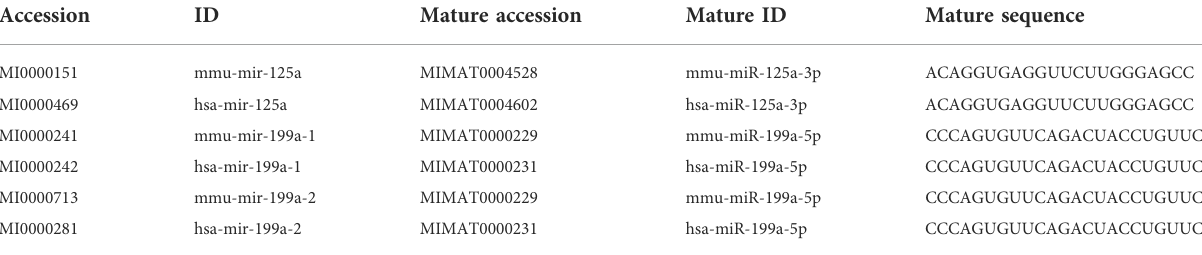
TABLE 2 Sequences of miR-125a-3p and miR-199a-5p in mice and humans by miRBase. Accession ID Mature accession Mature ID Mature